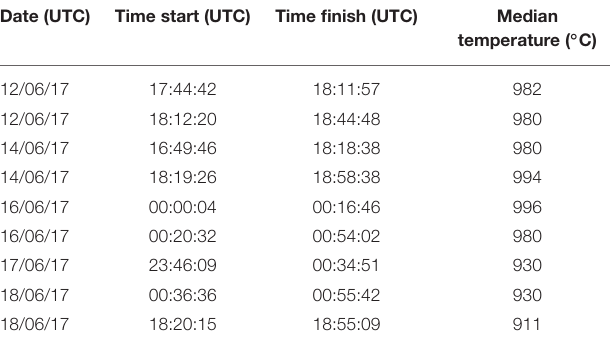
TABLE 2 | An overview of median temperatures acquired from near infrared acquisitions on indicated